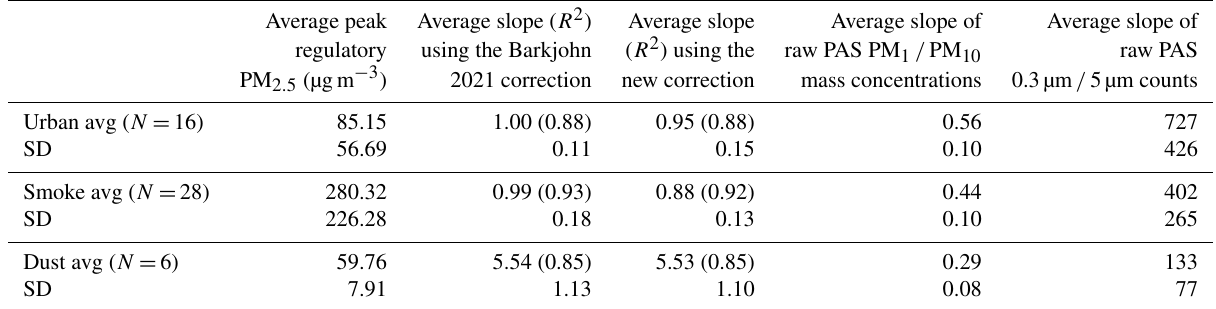
Table 2. Peak regulatory PM 2 . 5 , mean slope, and R 2 results from analysis of regulatory and PAS data, with the Barkjohn 2021 correction and new EPA correction, for 50 individual pollution events (Part I dataset). N gives the number of events of each type; SD is standard deviation. R 2 is the mean value for all events of that type. Also shown are the average slopes by aerosol type for the PM 1 / PM 10 and 0.3µm / 5µm count regressions, both of which are